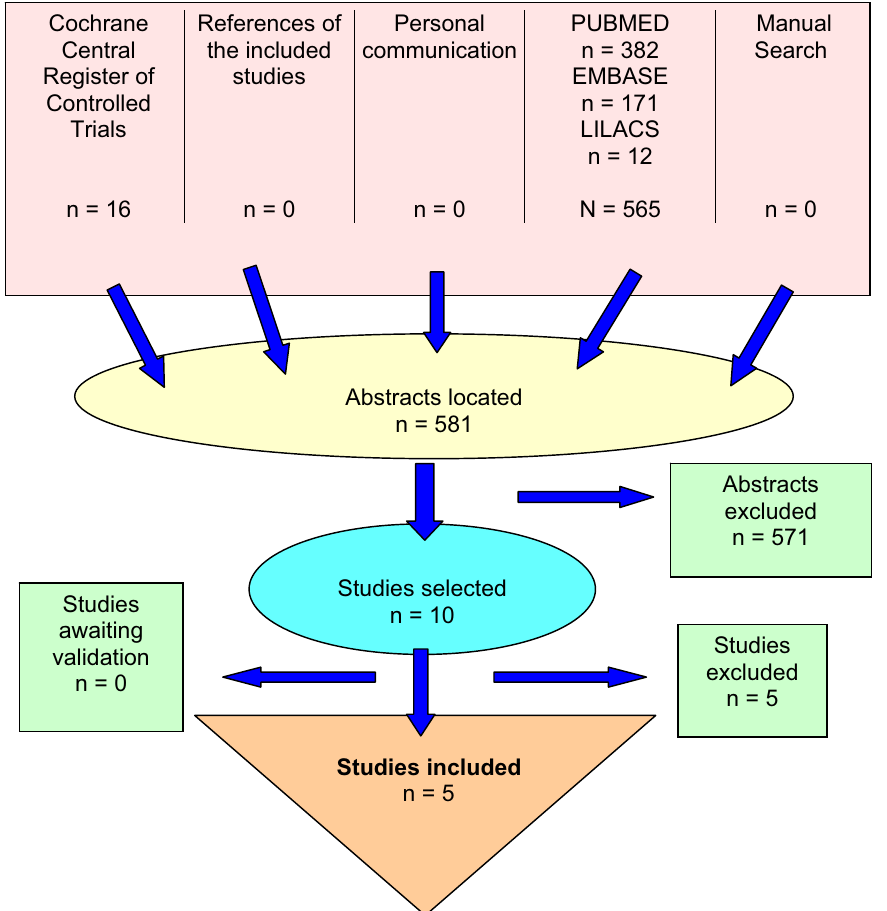
FIGURE 1 – Demonstrative flowchart of the result from the database search, selection and inclusion of articles in the systematic